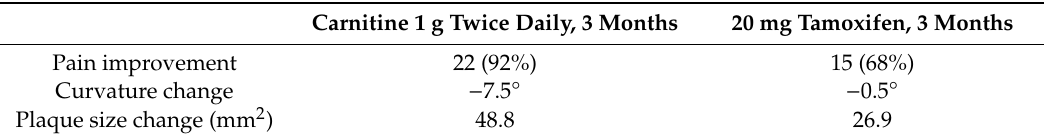
Table 13. Carnitine vs. Tamoxifen: Randomized, Double-Blind.